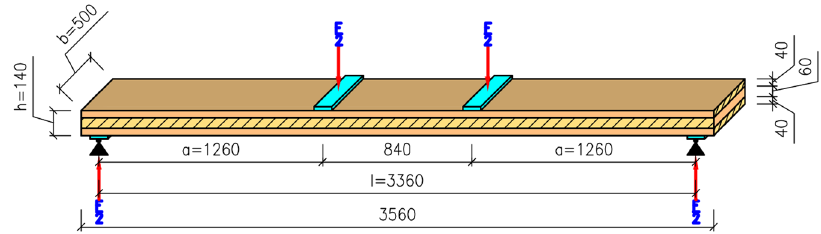
Figure 2. Test arrangement and geometry of CLT 140-3.